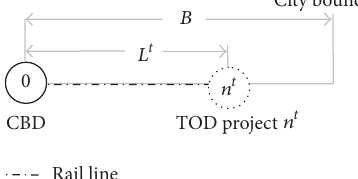
Figure 1: Configuration of rail and TOD projects over years in a linear monocentric